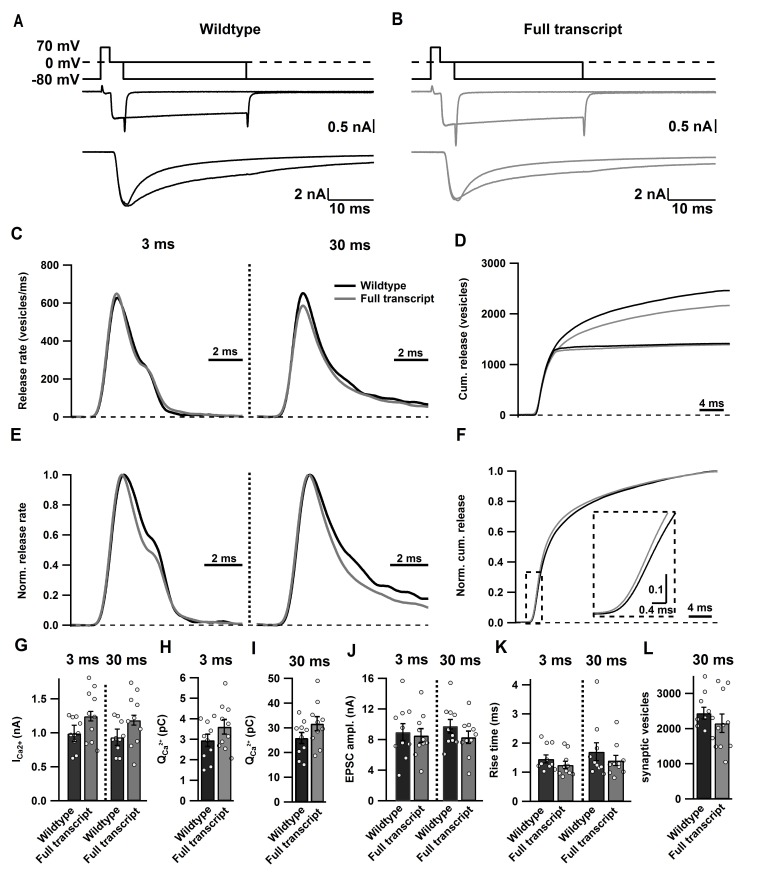
Cav2.1 Full transcript rescue does not affect synaptic transmission at the calyx of Held/MNTB synapse.(A–B) Averaged traces of SV pool measurements in noninjected control mice (black; a) and mice expressing Cre + Full length rescue construct (grey; B). Top: stimulation protocol driving SV release by depolarization from −80 mV to 70 mV for 2 ms, followed by 0 mV for 3 ms or 30 ms. Below: Traces depicting the resulting presynaptic ICa (middle) with corresponding EPSCs (bottom). (C–D) Summary graphs of SV release rates (c) and the cumulative synaptic vesicle release rates (D) after 3 ms and 30 ms stimulation. (E–F) Summary graphs depicting normalized SV release after 3 ms and 30 ms stimulation (E) and normalized cumulative SV release after 30 ms stimulation (F). (G–L) Quantification of ICa amplitude (G), charge of Ca2+ currents (H I), EPSC amplitude (J), 10–90% rise time of the EPSC (K) after 3 ms and 30 ms stimulation, respectively, as well as the number of SVs released by 30 ms stimulation (L). Data are represented as mean ± SEM.